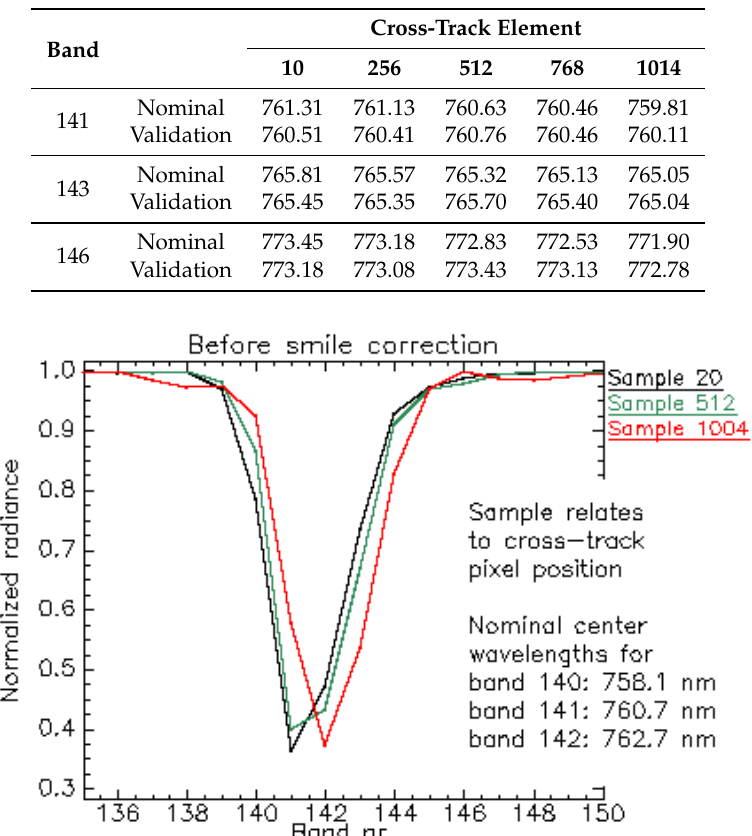
Table 8. Spectral smile in-orbit validation. Center wavelengths given in [nm]; “Nominal” refers to the in-orbit calibration and “Validation” to the results derived for the Gobabeb scene DT2019020405 with smile correction, but no destriping.